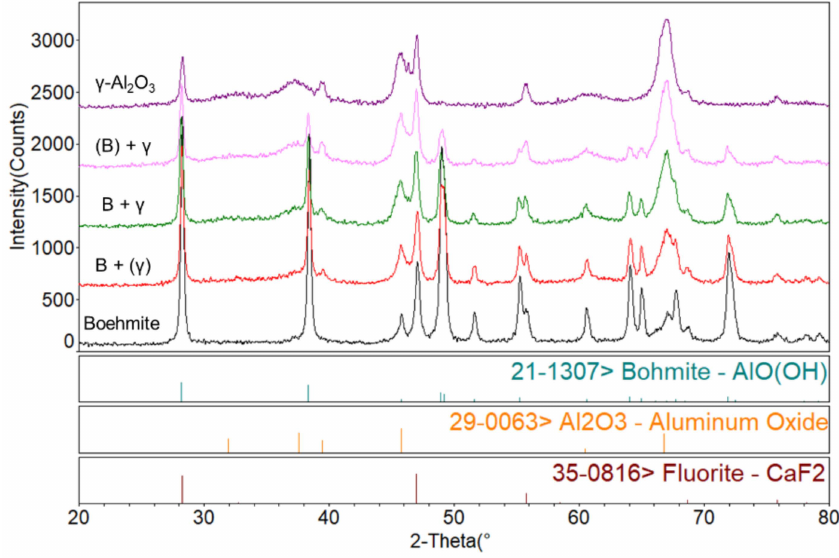
Figure A1. XRD qualitative analysis in phase transformation process.